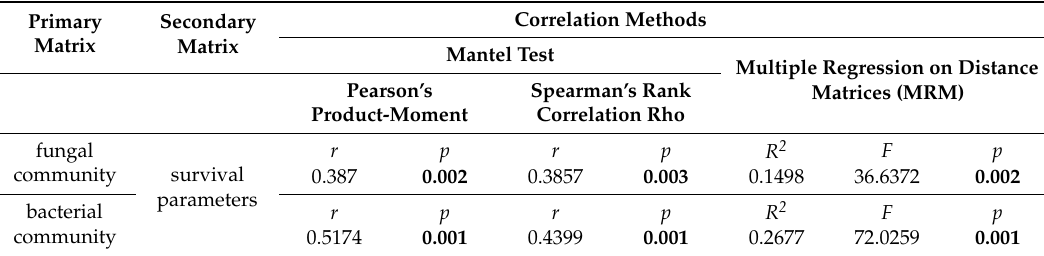
Table 2. Correlation analysis of fungal and bacterial community (OUT matrix) and E. coli O157 survival parameters ( ttd , p , and δ ) based on the Mantel test based on Pearson’s product–moment correlation and Spearman’s rank correlation rho and multiple regression on distance matrices (number of permutation = 9999). Bolded numbers indicated p values were significant at 0.05 level.